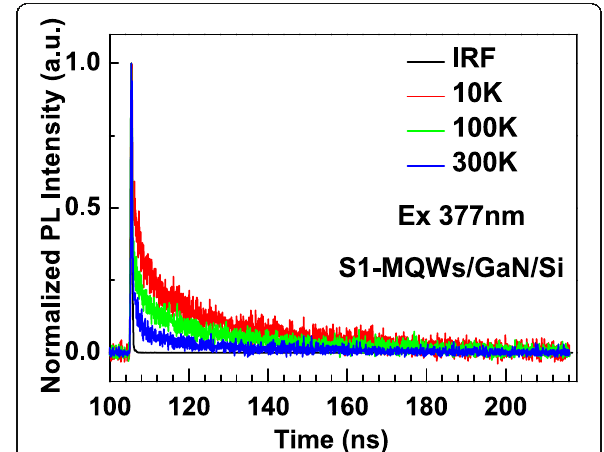
Fig. 3 PL decay curves for S1 excited by 377 nm pulsed laser at 10 K, 100 K, and 300